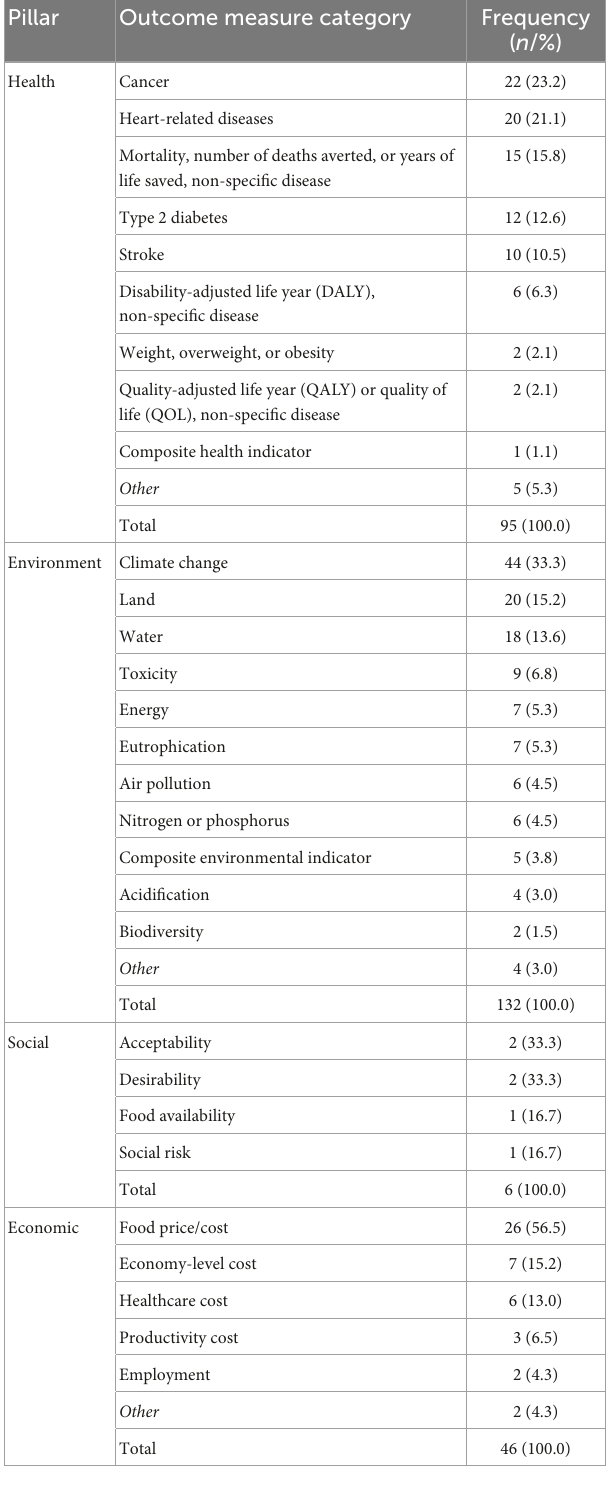
TABLE 3 Frequency of outcome measures in each